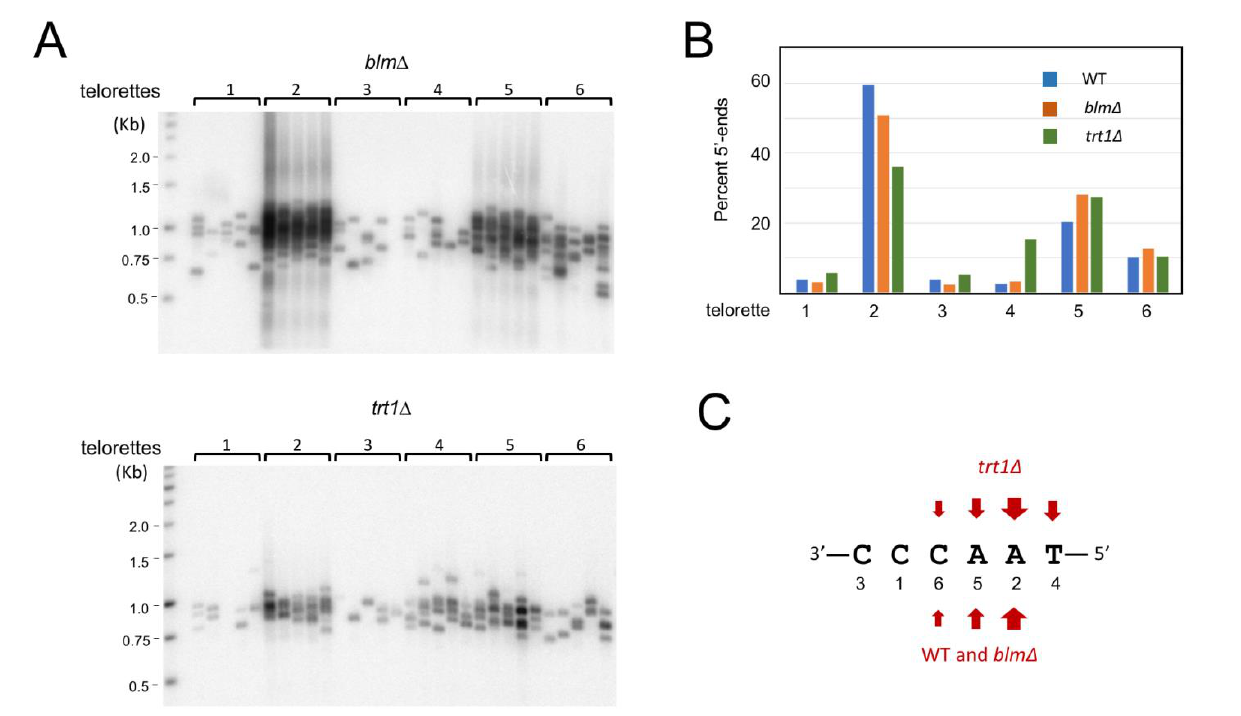
FIGURE 6: Characterization of the telomere C- strand 5’ end nucleotide in blm ∆ and trt1 ∆ . (A) (Top) DNA from blm ∆ was ligated sepa- rately to each of six individual telorette oligo, amplified using the UT4/5-F and teltail primers, and then subjected to Southern analysis. (Bottom) DNA from trt1 ∆ was ligated separately to each of six individual telorette oligo, amplified using the UT4/5-F and teltail primers, and then subjected to Southern analysis. (B) The number of STELA products generated by each telorette oligo was determined for the blm ∆ and trt1 ∆ DNA, and plotted as the percentage of total STELA products. (C) The predominant 5’ end nucleotides for the various U. maydis strains are